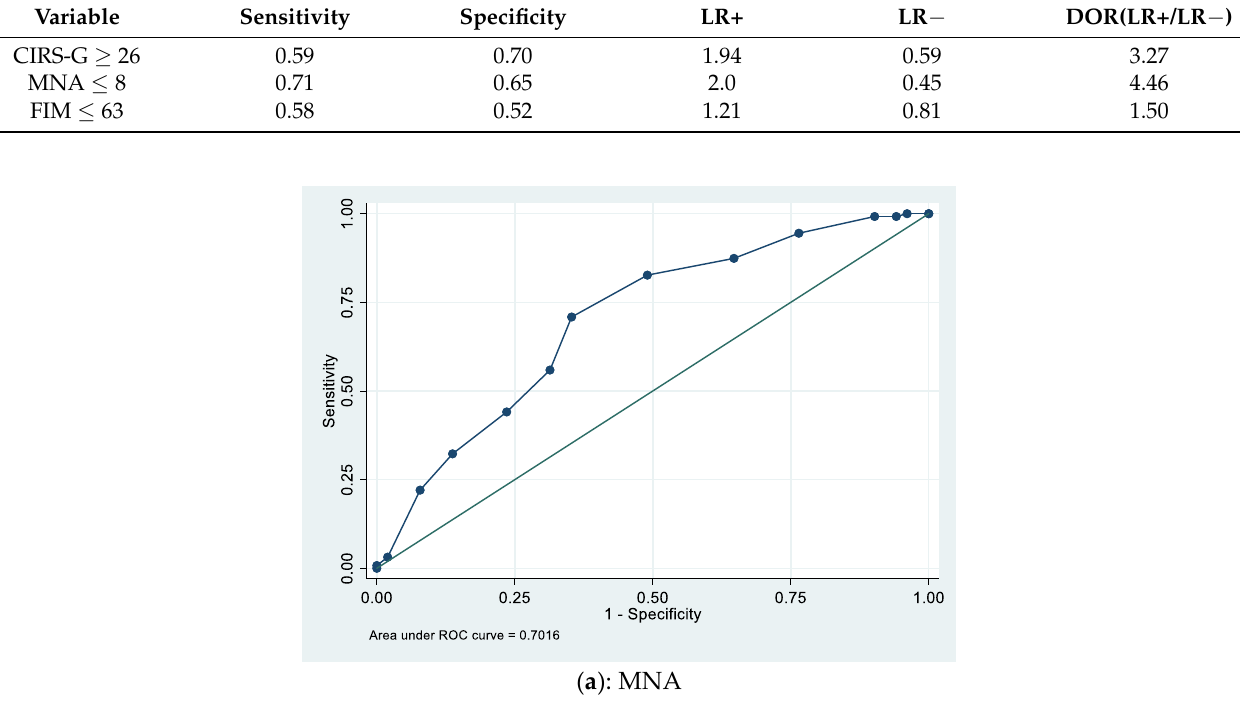
Table 2. Association between scores evaluating comorbidities, malnutrition and functionality and 1-year mortality (univariate and multivariate analysis).